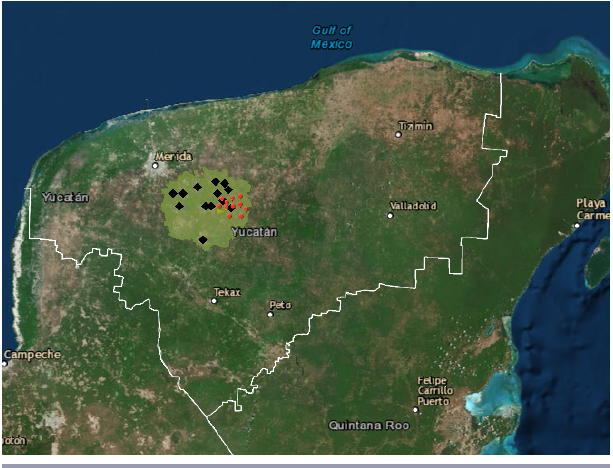
Fig. 2 . Map showing the Geohydrological Reserve zone in Yucatan, Mexico, and the cenotes explored (precise locations are not given).